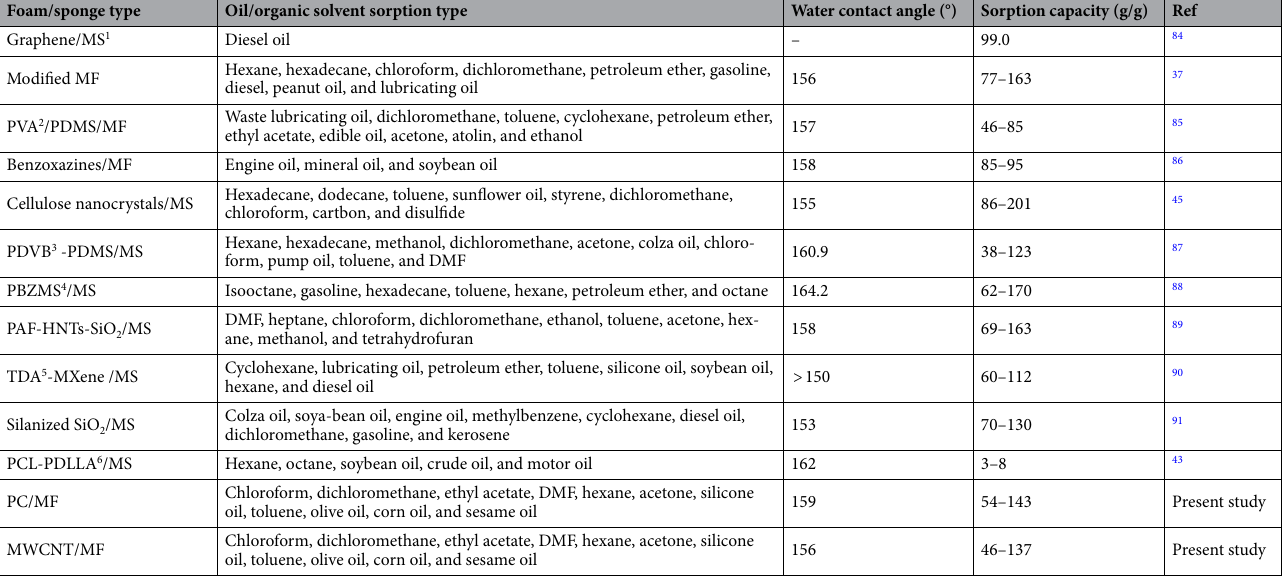
Table 2. Sorption capacity of various melamine substrates. 1 Melamine sponge. 2 Polyvinyl alcohol.